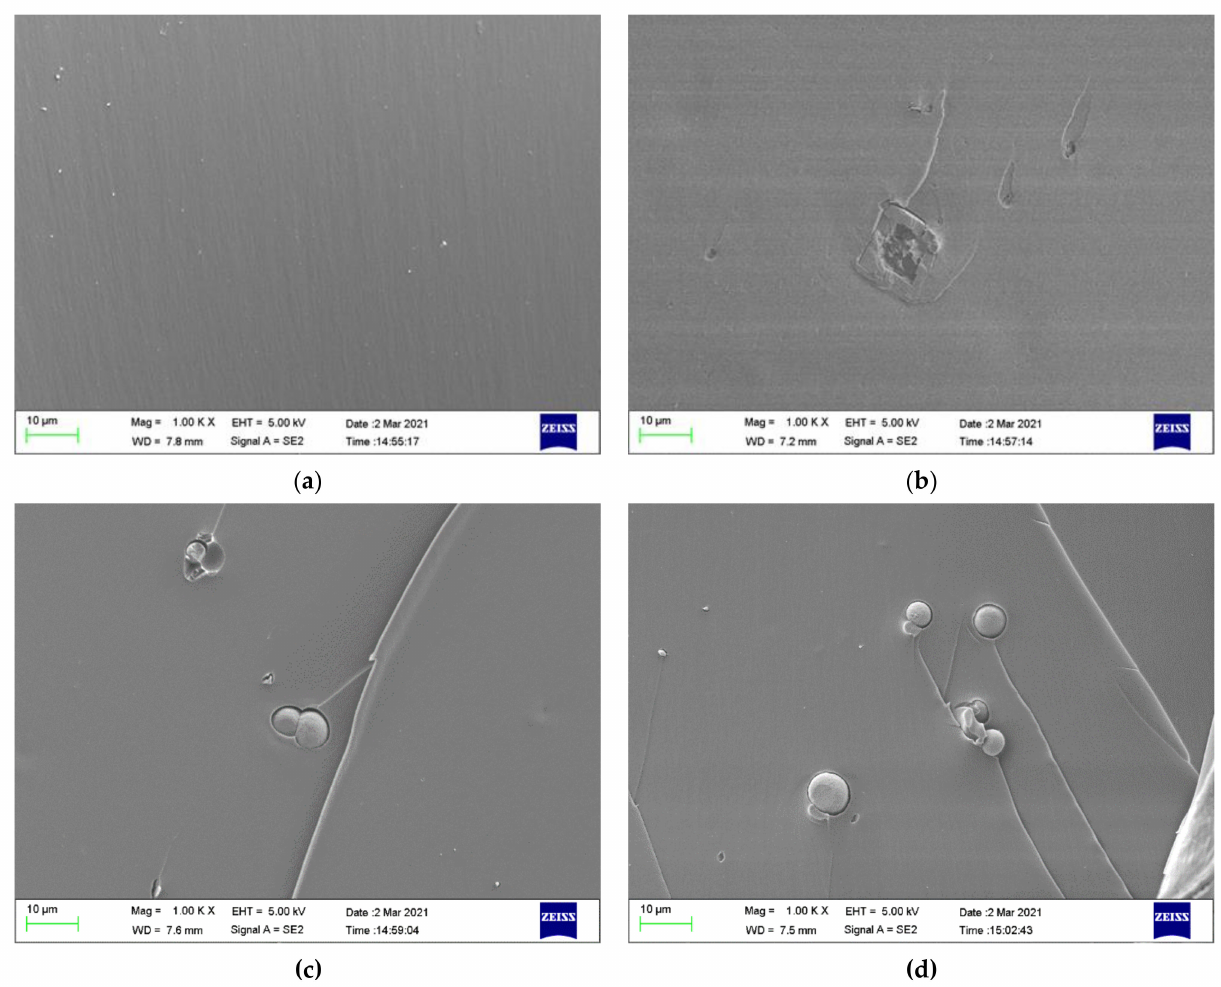
Figure 12. Cross-section SEM of ( a ) epoxy coating ( b ) epoxy-CaCO 3 coating, ( c ) epoxy-3 wt%SLS/CaCO 3 coating, and ( d ) epoxy-5 wt%SLS/CaCO 3 coating after exposure to the SCP solutions for 48